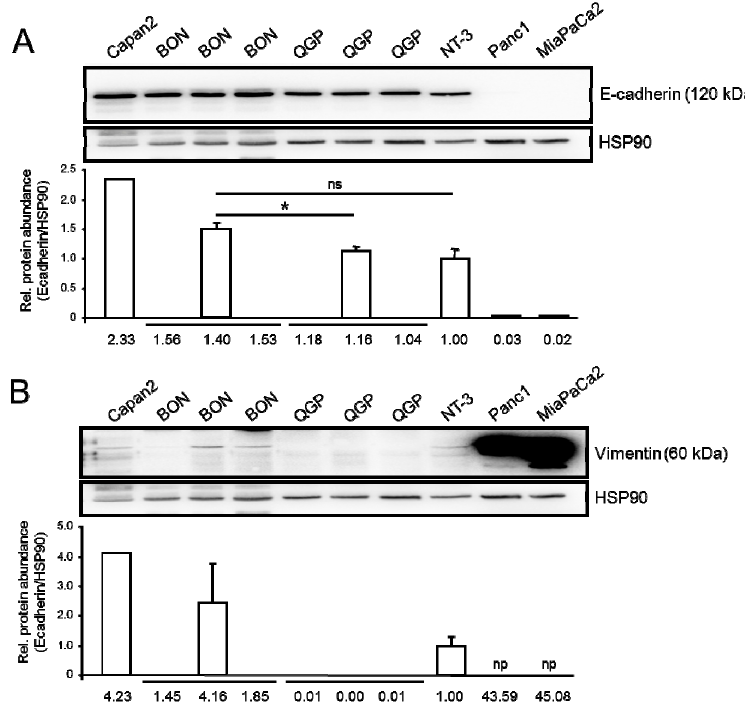
Figure 2. Expression of epithelial and mesenchymal markers in BON, QGP and NT-3 cells. ( A ) Immunoblot analysis of the epithelial marker E-cadherin. Capan2 or Panc1 and MiaPaCa2 cells were used as positive or negative control, respectively. ( B ) Immunoblot analysis of the mesenchymal marker Vimentin. Capan2 or Panc1 and MiaPaCa2 cells were used as negative or positive control, respectively. The graphs below the blots indicate densitometry-based quantification of band intensities (mean ± SD, n = 3) from three independent experiments (for NT-3 cells only the most representative one is shown). Data are plotted relative to NT-3 cells set arbitrarily at 1.0. The values for Panc1 and MiaPaCa2 were not plotted (np) as they do not fit the scale. The asterisk ( ∗ ) indicates a significant difference; ns, not significant.